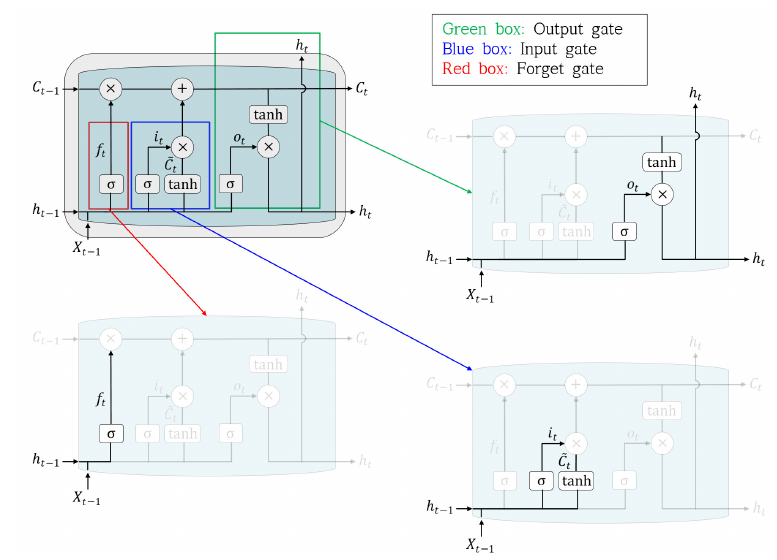
Figure 4. Structure of the long short-term memory (LSTM) model, including the forget, input, and output gates.